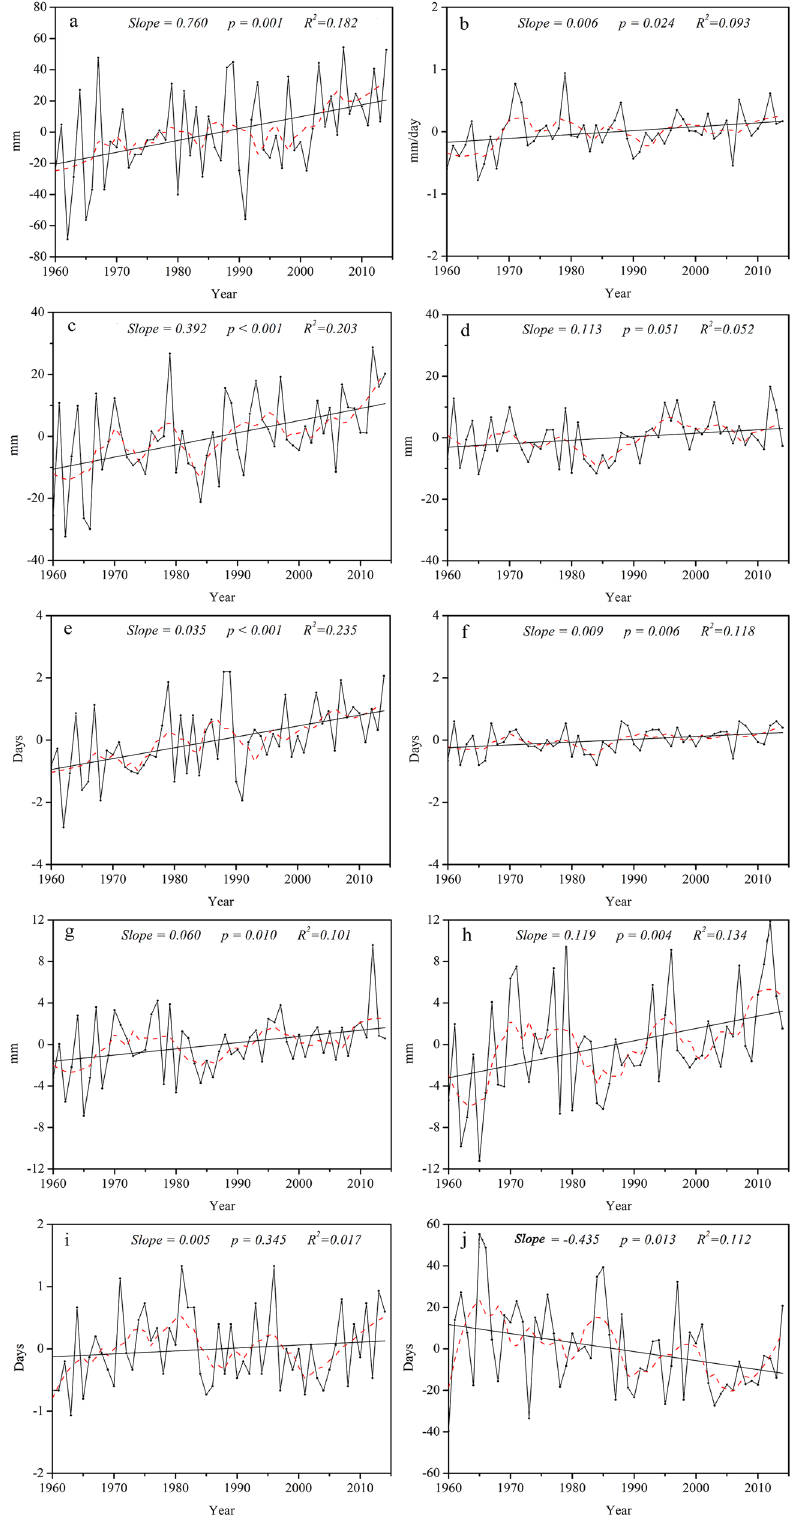
Figure 9. Annual regional averaged series for indices of precipitation extremes. Precipitation indices: wet day precipitation ( a ), simple daily intensity ( b ), heavy precipitation days ( c ), very heavy precipitation days ( d ), very wet day precipitation ( e ), extremely wet days precipitation ( f ), maximum 1-day precipitation ( g ), maximum 5-day precipitation ( h ), consecutive wet days ( i ), consecutive dry days ( j ). For description of indices, see Supplementary Table S1. Straight line represents linear regression and the dash line is the 10-year smoothed